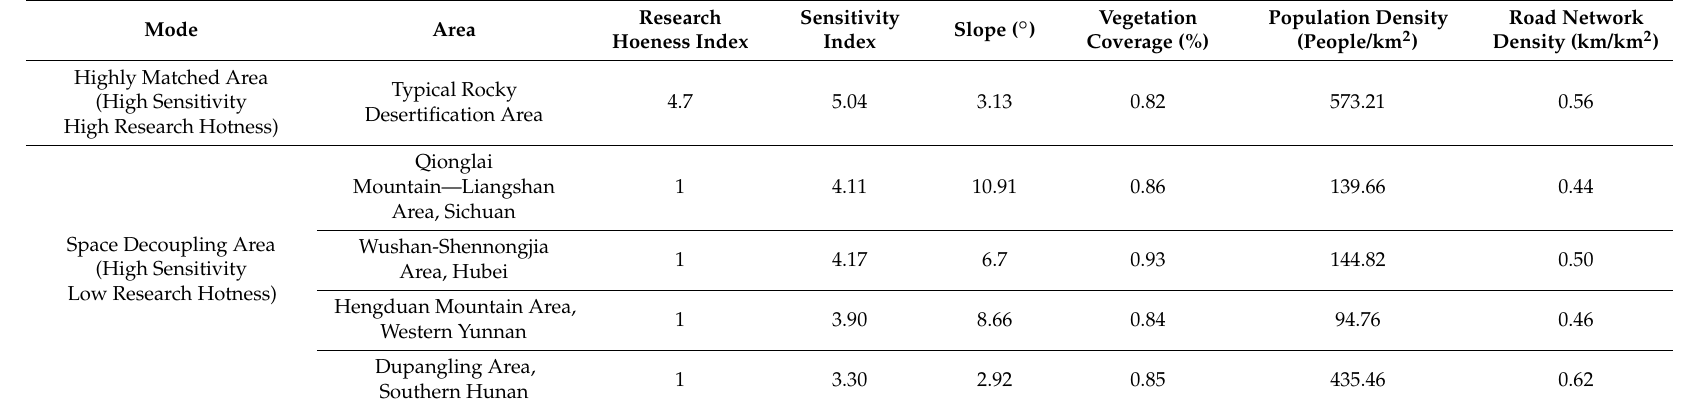
Table 1. Hotness Index, Sensitivity Index, Environmental and Social Backgrounds Index in Key